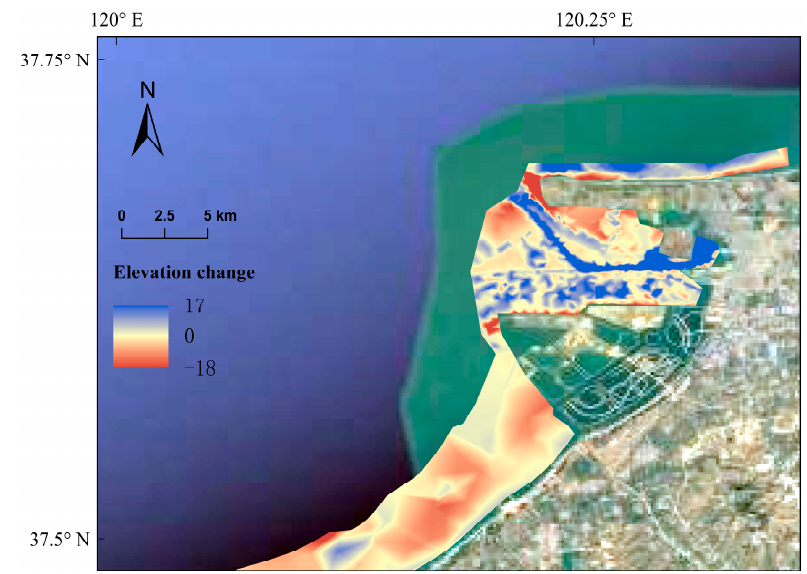
Figure 19. Human impact on the distribution of scouring and siltation (Coastal Figure 19 Human impact on the distribution of scouring and siltation (Coastal projects)